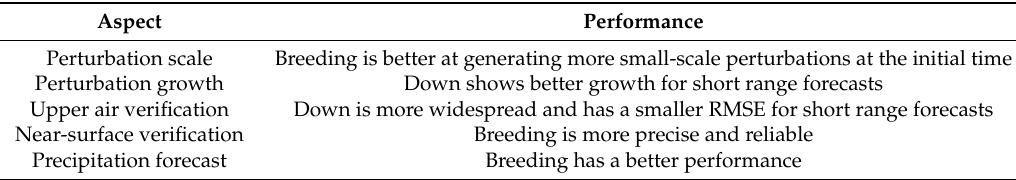
Table 1. Summary of the comparison of both ensembles for all